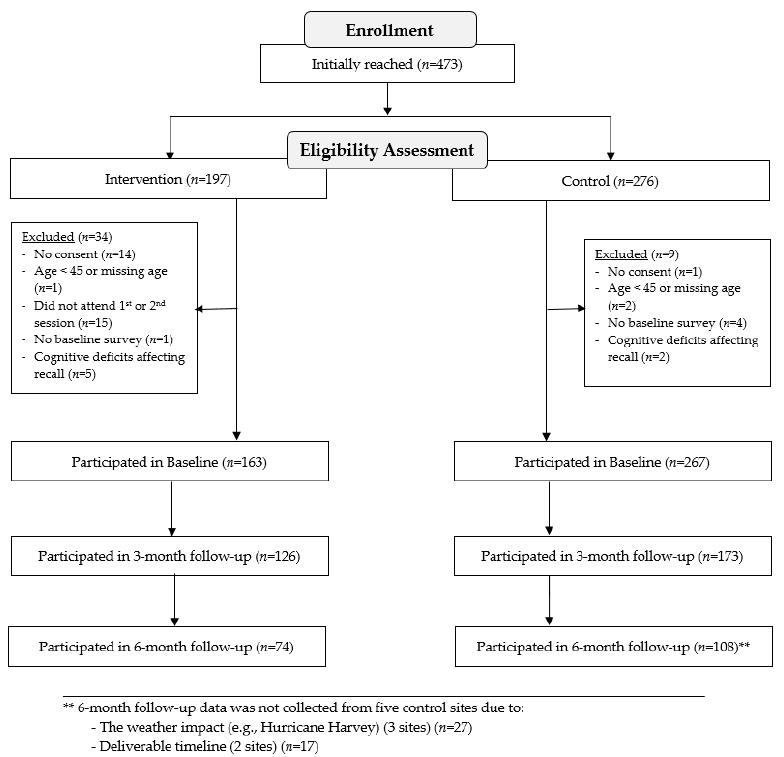
Figure 1. Consort diagram.